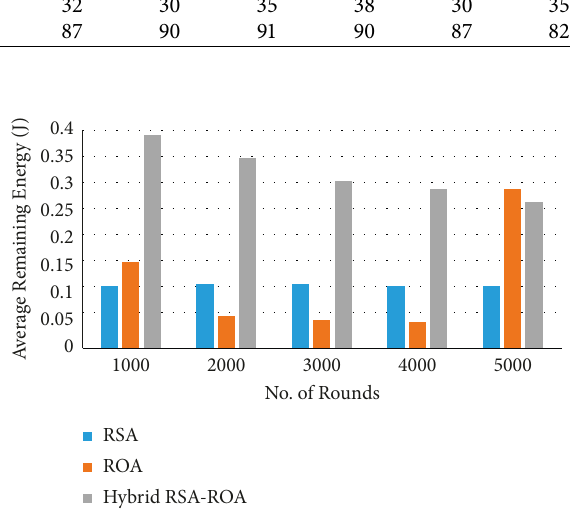
Figure 2: Graphical representation for network 1. Figure 3: Graphical representation of the proposed model for